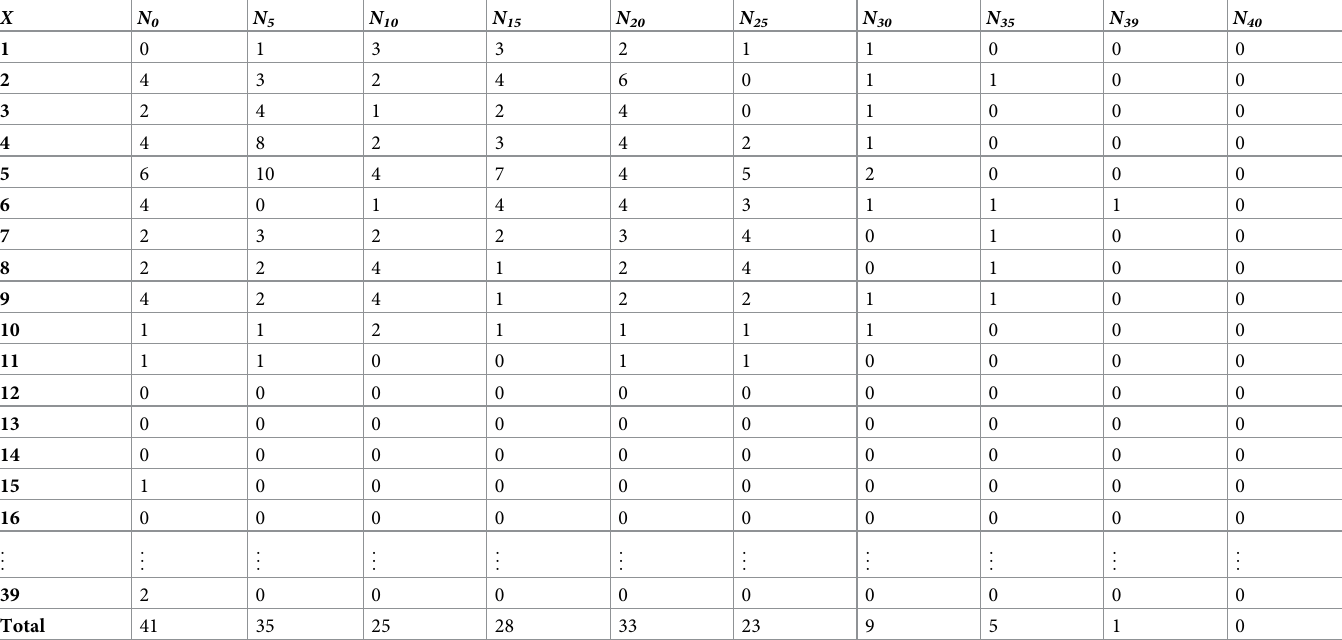
Table 13. Dynamic quantitative prediction model of P . flavus BM